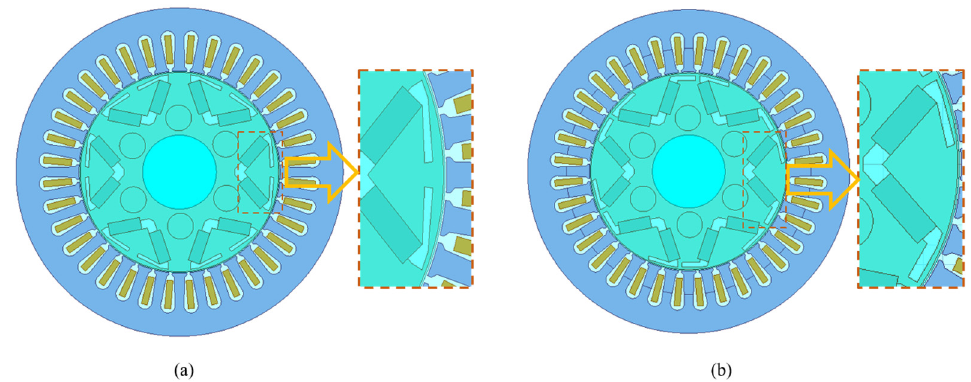
Figure 6. Two optimised schemes for rotor slotting: ( a ) scheme one; ( b ) scheme two.